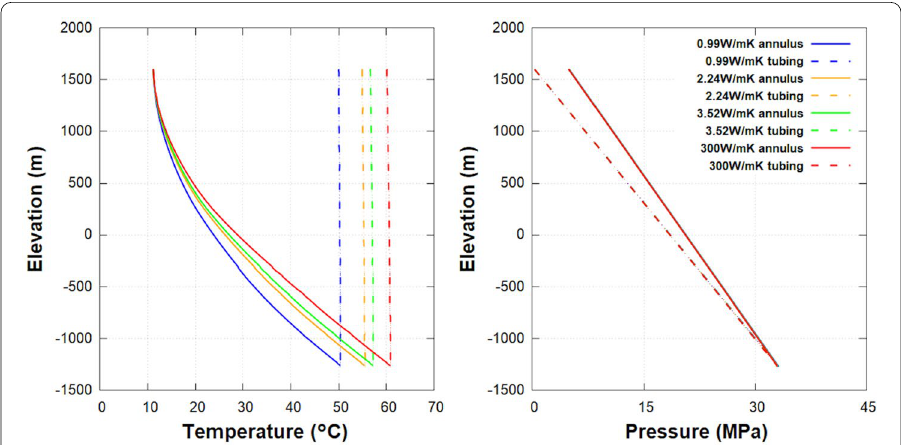
Fig. 8 Thermal conductivity analysis in cement layers for fixed ˙ m = 5 ( kg / s ) over 30 years. Left— temperature vs. elevation for various (cid:31) ( W / mK ) . Right—pressure vs. elevation for various (cid:31) ( W / mK ) . Solid lines represent annulus and dashed lines represent tubing data, respectively. Legend applies to both graphs. The base-case graph here is highlighted in blue